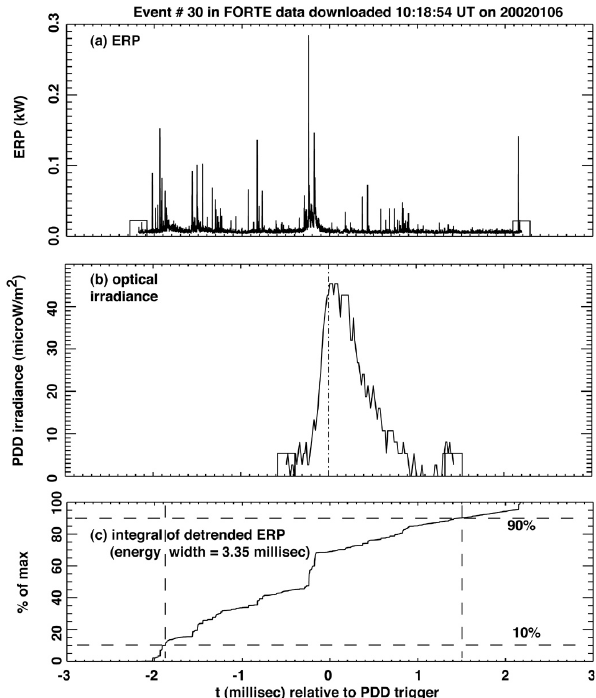
Fig. 1. Typical joint HUMR–PDD recordings, with HUMR trig- gered by PDD. (a) ERP versus time, with PDD trigger time defined as zero. (b) PDD optical irradiance versus time, with PDD trigger at zero (vertical dashed line). (c) Definite integral of ERP versus time, showing derivation of the “energy width” as the time between the definite integral’s passages through 10% and 90% of its final peak